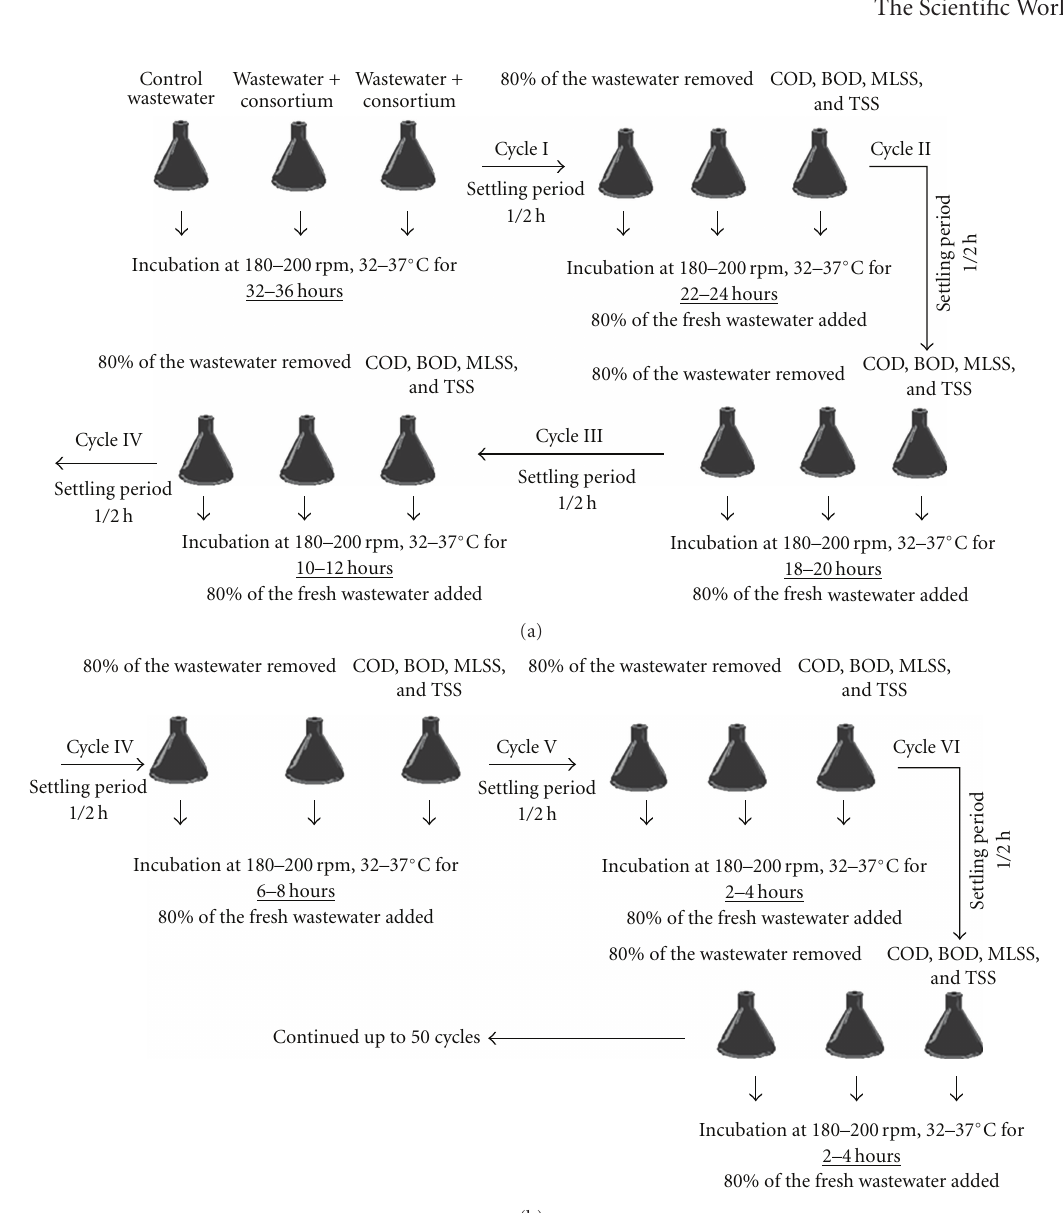
of retention time, 3-4% of the COD was removed.